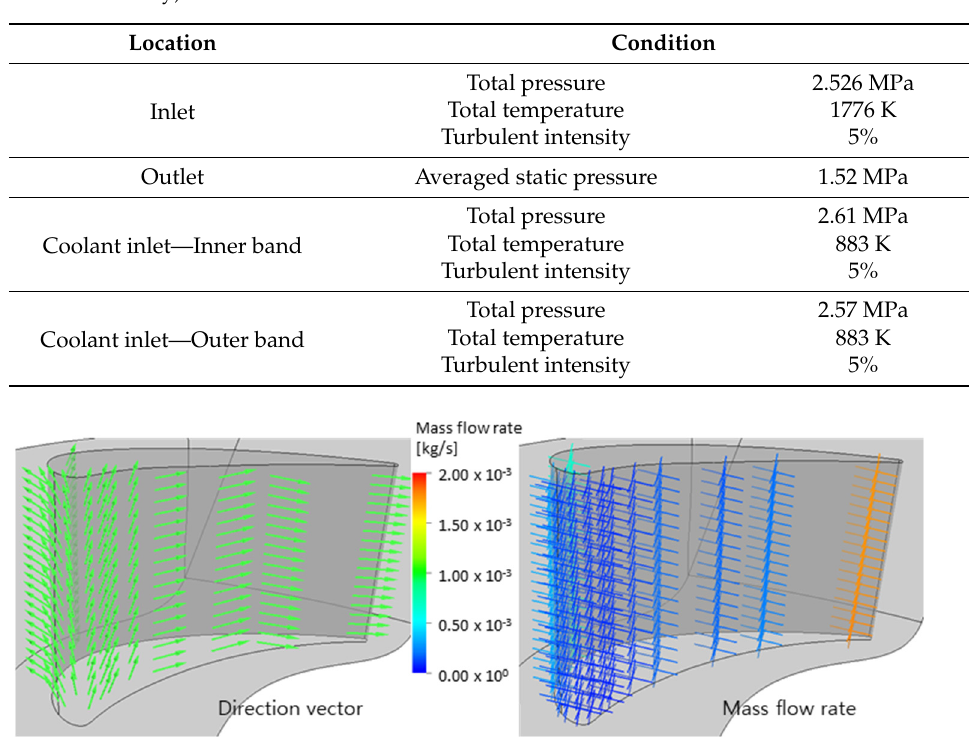
Figure 6. Injection region in the computational domain (eject direction and mass flow rate of the coolant). (reprinted with permission from [16]; copyright 2021 Korean Society for Fluid Machinery).